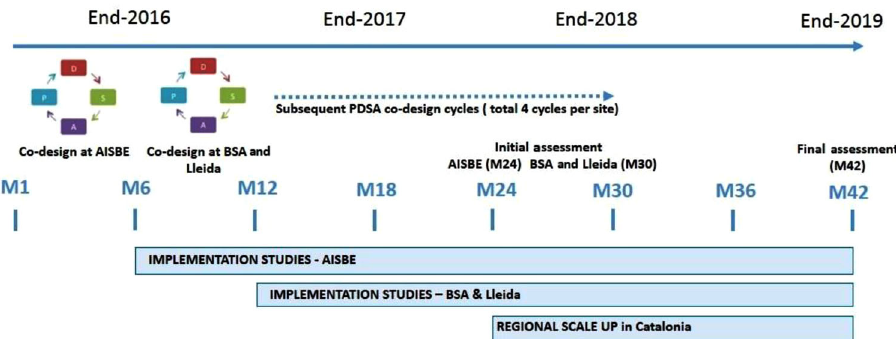
Fig. 2 Timeline of the protocol for large-scale deployment of CCP management in Catalonia. AISBE stands for integrated care area of Barcelona-Esquerra and BSA is the abbreviation of Barcelona Serveis Assistencials. A total of four codesign cycles, of 6-month duration each, are planned in each site. At the end of the assessment of the implementation studies (M42), a consensus on key performance indicators for follow up of integrated care interventions ’ adoption beyond the current study will be